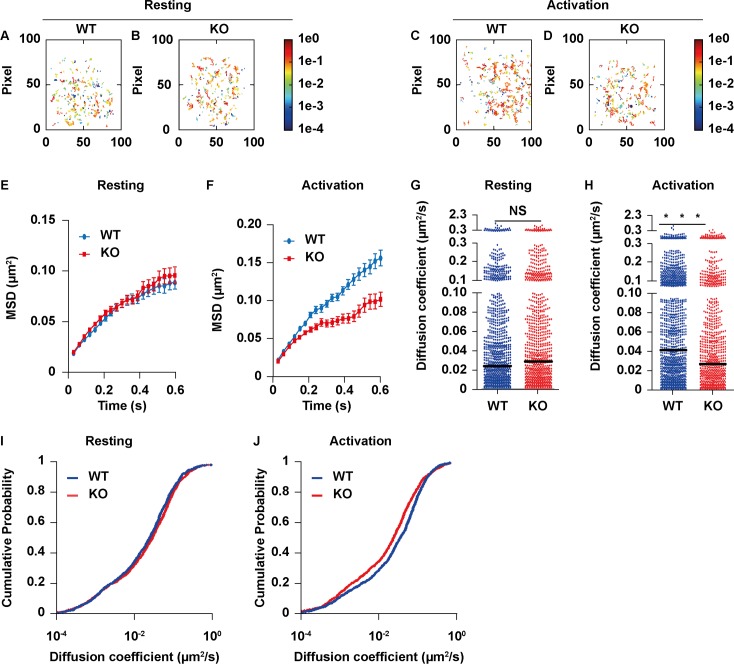
B cell receptor (BCR) mobility is reduced in Rictor knockout (KO) B cells after antigenic stimulation.The primary B cells labeled with low concentration Alexa Fluor 647–Fab anti-immunoglobulin M (IgM) (Fc fragment antibody [Fc] specific) and high concentration Alexa Fluor 647–Fab anti-IgM (Fc specific) was placed on planar lipid bilayers containing anti-major histocompatibility complex (MHC) or anti-IgM, and single BCR molecule total internal reflection fluorescent (TIRF) images were acquired. Individual BCR molecules in TIRF images from 1 typical primary B cell indicate the instant diffusion coefficient (D0) by pseudocolored spots from 5 min to 15 min after stimulation. The display range of the pseudocolor is based on the D0 value of 10–4–0 μm2/s, a range that included most of the D0 values of the tracked BCRs. The accumulated trajectory footprints of individual BCR molecules in the entire time course (A–D). All of the D0 values were displayed as mean-square displacement (MSD) plots (E and F), single BCR molecules of the indicated numbers (G and H), and cumulative distribution probability (CDP) plots (I and J) from 3 independent experiments. Mann–Whitney U test was used to do the statistics, *p < 0.01. The numerical data (for A, B, C, D, E, F, G, H, I, and J) can be found in S1 Data.